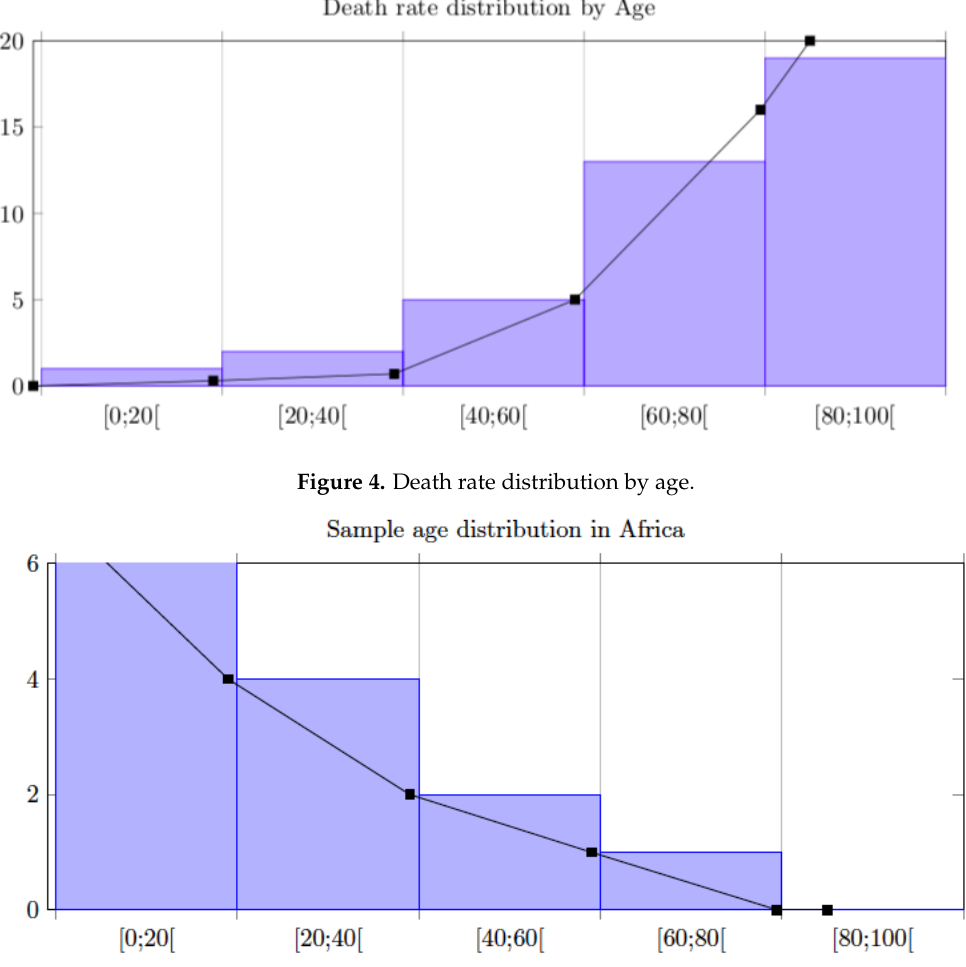
Figure 5. A sample age distribution (unnormalized) for a specific sector.